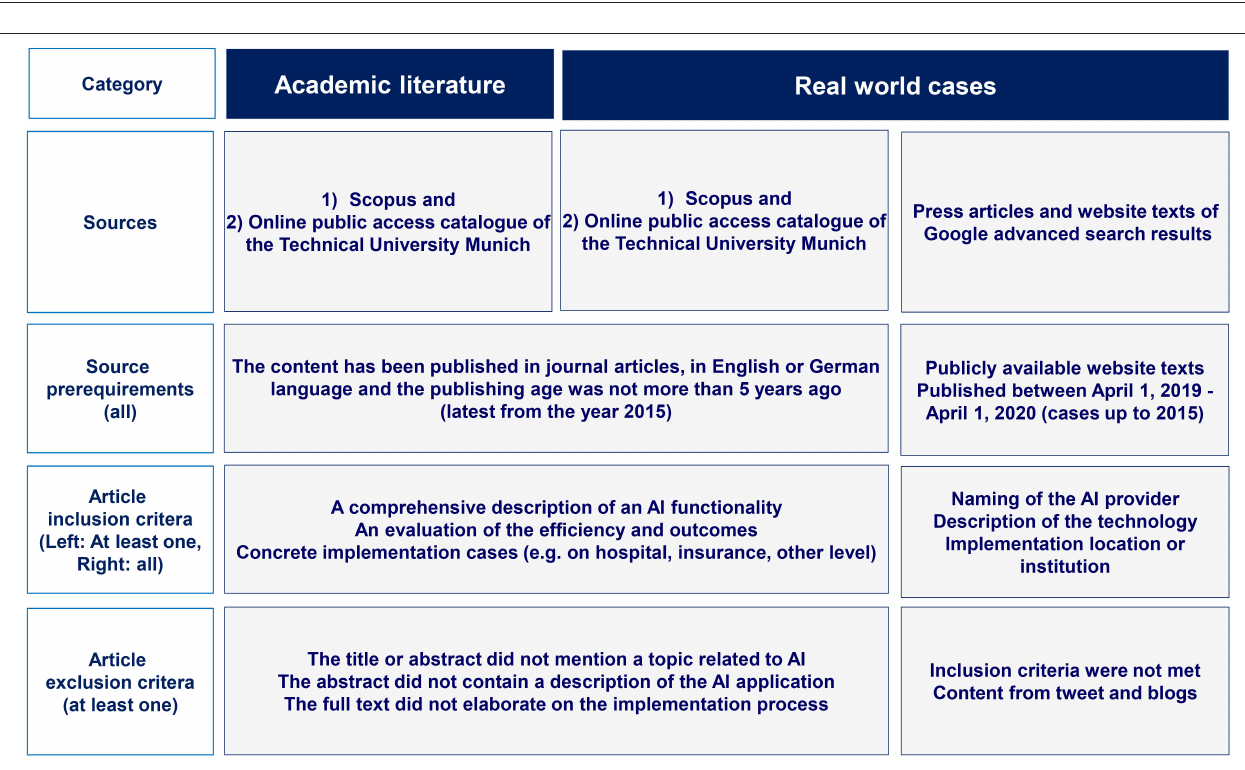
FIGURE 1 | Barriers to adoption of big data for health globally—survey of 125 countries by the WHO (14).